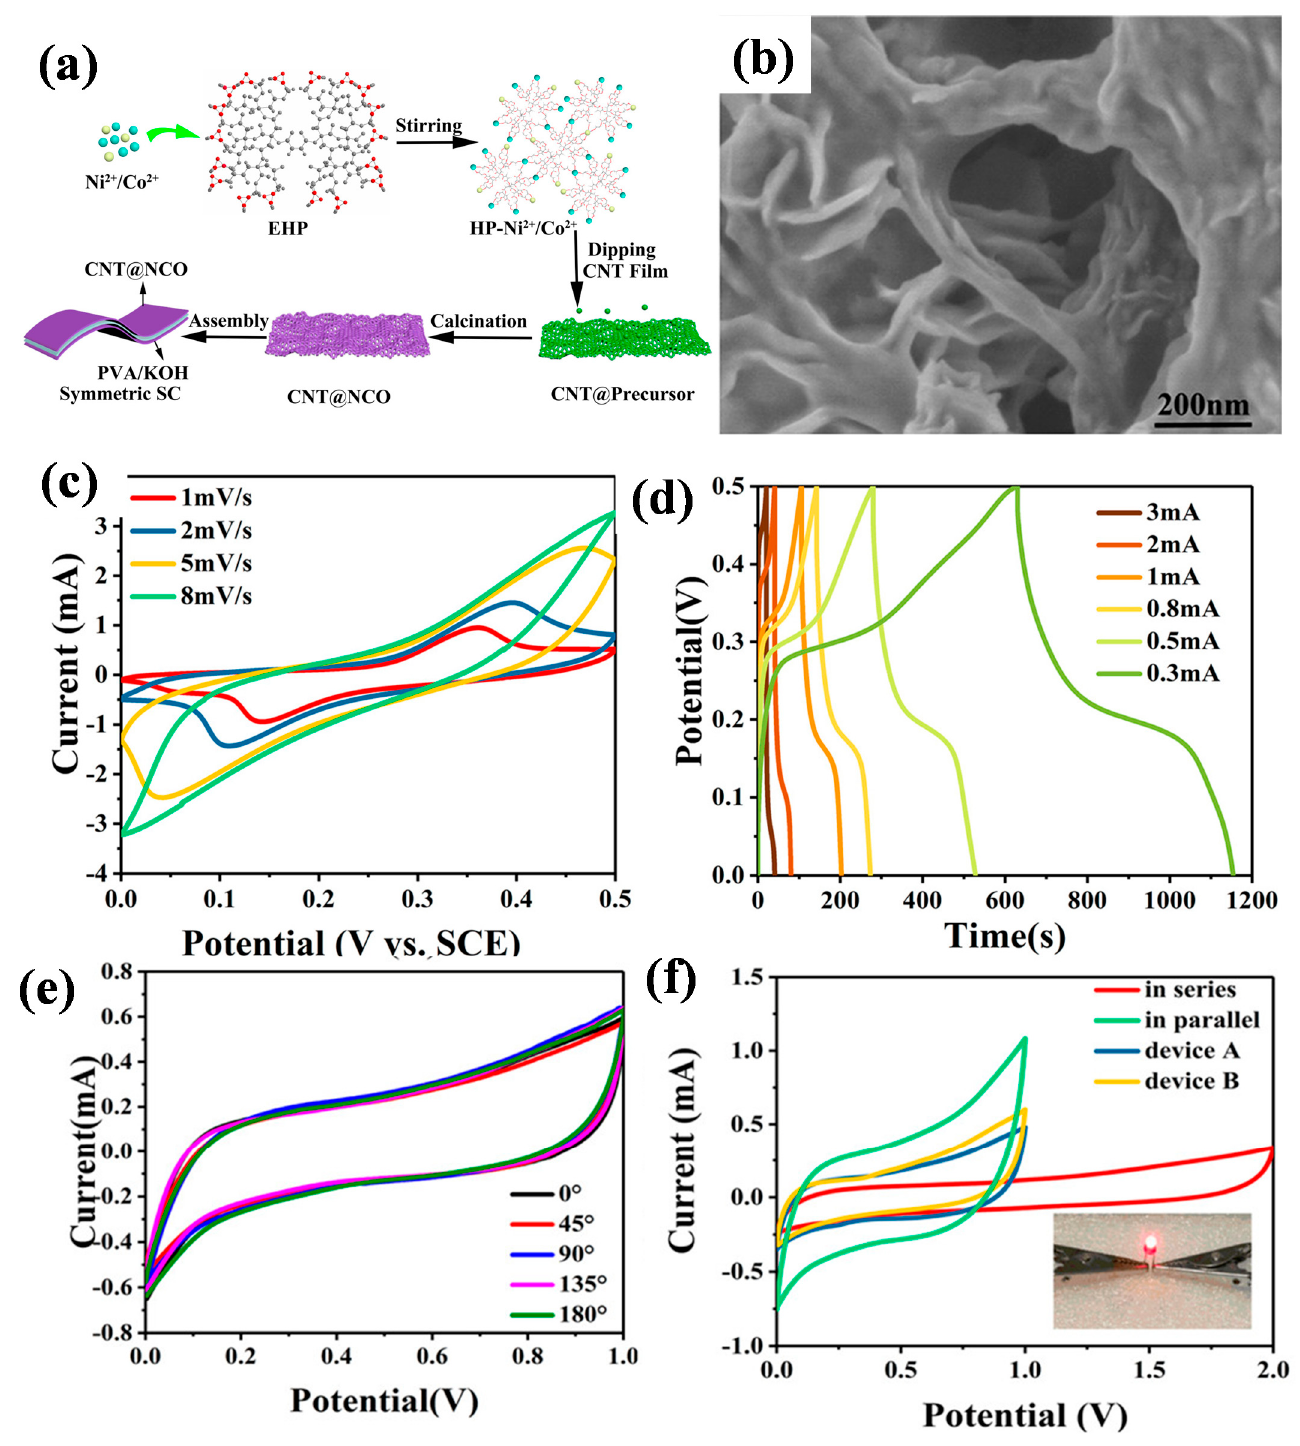
Figure 5. ( a ) Fabrication process of CNT@NiCo 2 O 4 and assembly of a symmetric supercapacitor, ( b ) SEM images of CNT@NiCo 2 O 4 , ( c ) CV curves at various scan rates ranging from 1 to 8 mV s − 1 , ( d ) charge − discharge voltage profiles at a current ranging from 0.3 to 3 mA, ( e ) CV curves when the film SC was bent to different angles, ( f ) CV curves of two devices connected in series and in parallel, respectively. Reproduced from Ref. [153]. Copyrights (ACS, 2020).